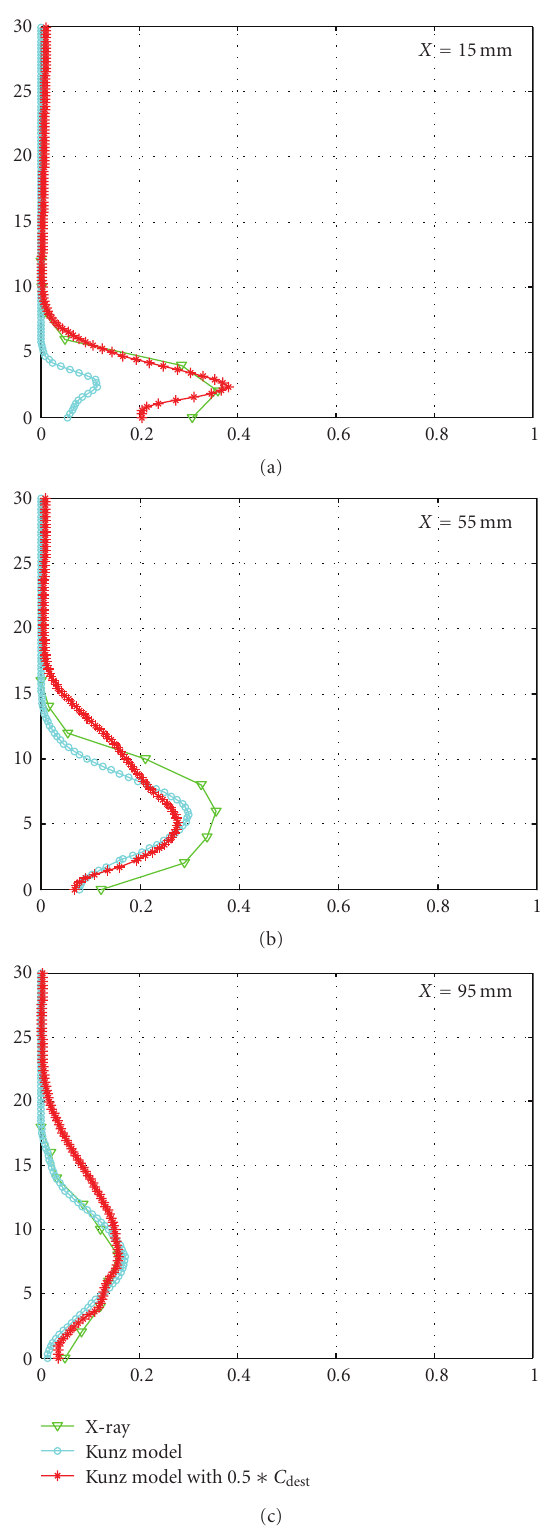
Figure 13: Void Fraction distributions ( L/c = 0 . 8, V ref = 6 m/s).